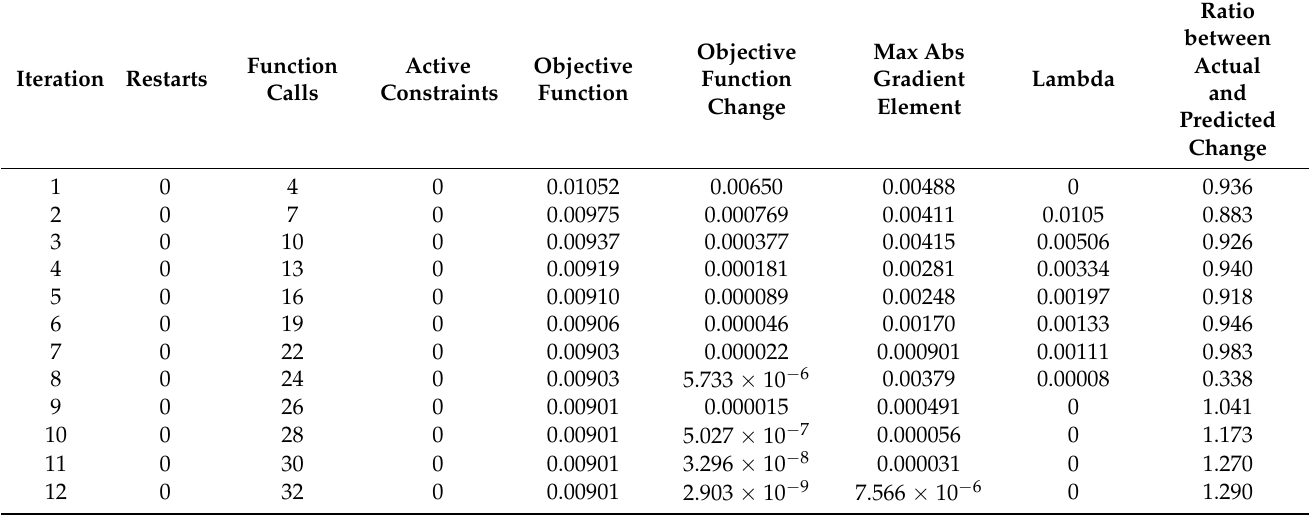
Table 6. Iterations of the first-order CFA model run on the pre-trial data set.